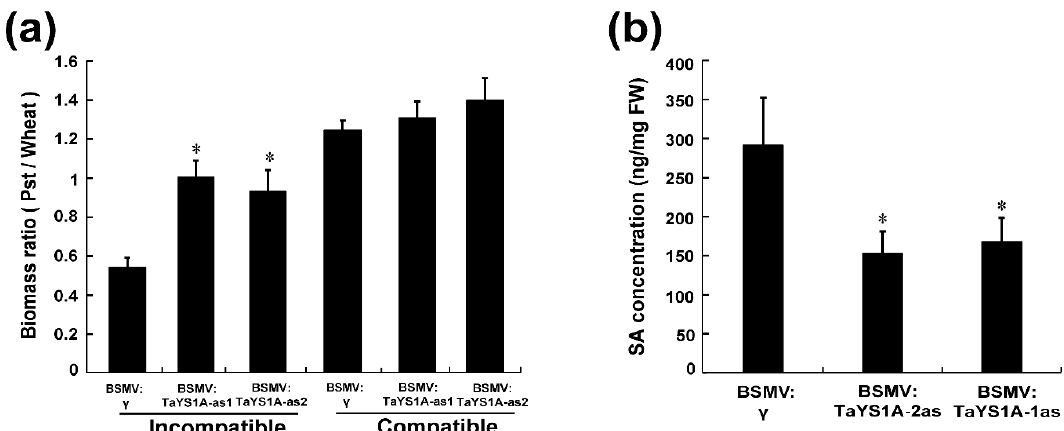
Figure 7. Fungal biomass and SA quantification in TaYS1A -silenced plants. ( a ) Relative fungal biomass was measured from the total genomic DNA of TaYS1A- silenced leaves infected with CYR23 or CYR31, which was sampled at 14 dpi. ( b ) SA concentration in TaYS1A- silenced leaves infected with CYR23, which was sampled at 14 dpi. Values denote the mean ± standard errors of three independent biological samples. Asterisks indicate significant differences from BSMV: γ using the Student’s t -test ( p < 0.05).